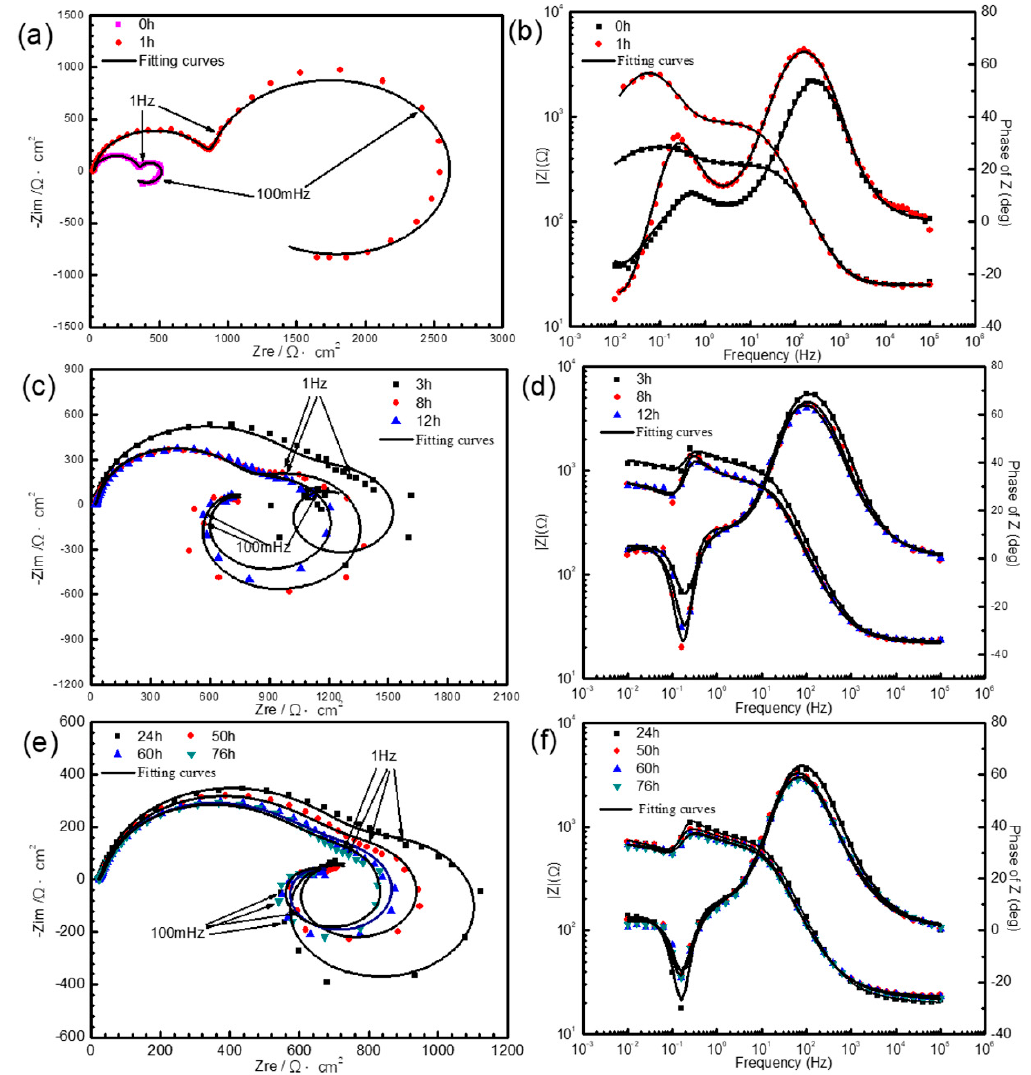
Figure 3. EIS dependence on immersion time of AZ91D in simulated HA solution: ( a , c , e ) Nyquist ( b , d , f ) Bode.